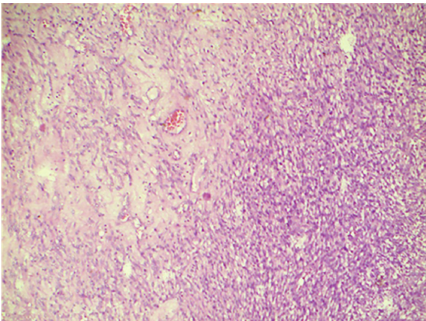
Figure 1: Hypercellularand hypocellular areas with prominent vascularity (H&E × 100).